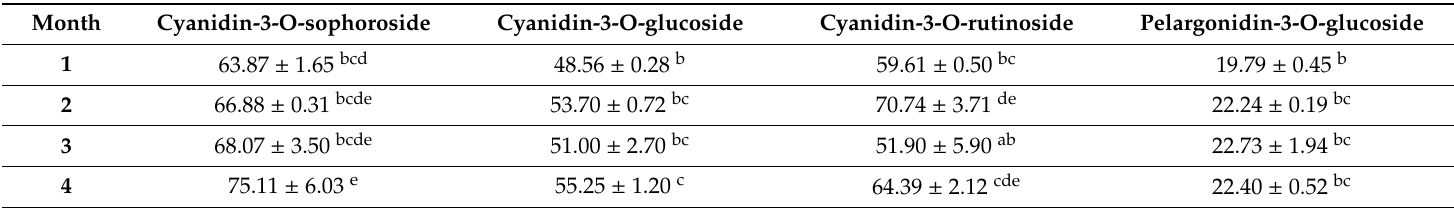
Table 18. Fruits stored at –20 ◦ C in freezer, packaged in PET film. E ff ect of storage period on the di ff erent anthocyanidin compounds content in red raspberries (cv. Erika). Results are expressed in µ g / g of fresh weight. The results are the mean of three replicates ± Standard Deviation. ** ( P ≤ 0.01). The letters represent the significant di ff erence vertically at P ≤